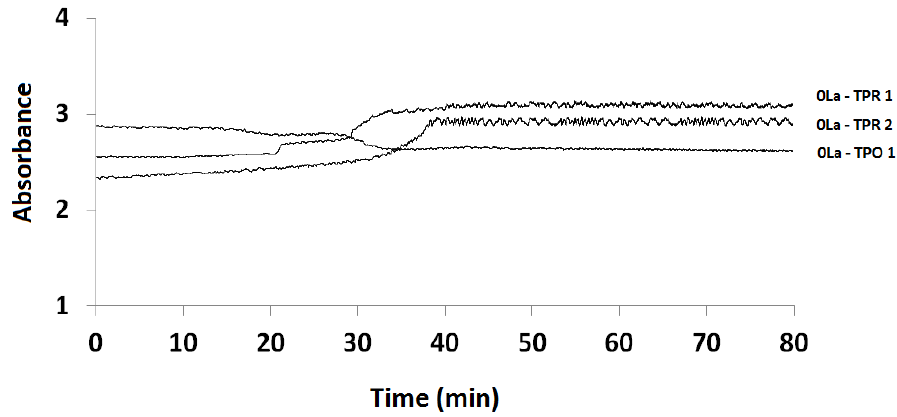
Figure 7. Kinetic spectra (absorbance vs. time) for the 0La catalyst during TPR 1, TPO 1 and TPR 2 combined on the same coordinates.